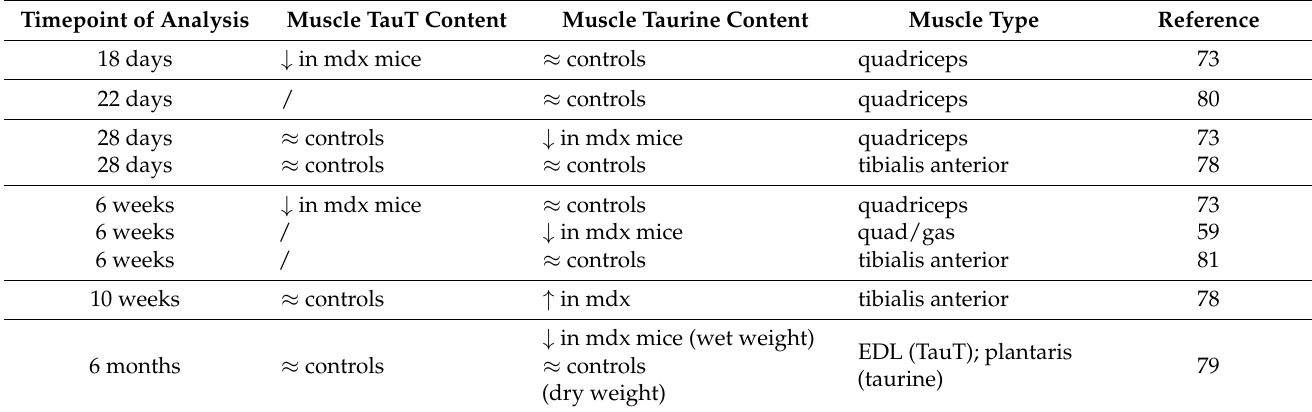
Table 1. Summary of TauT and taurine expression in the mdx